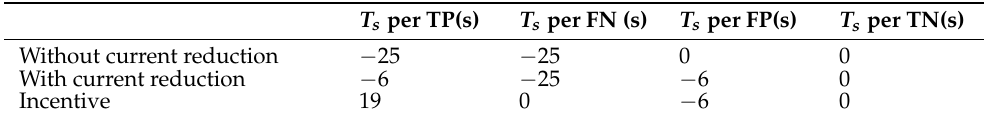
Figure 10. Expected lost beam time without ( top ) and with ( bottom ) the proposed 10% current reduction. An interlock equivalently leads to 25 s of lost beam time, i.e., − 25 s of beam time saved. With the current reduction, the interlock is expected to be avoided with a cost of six s of lost beam time, i.e., − 6 s of beam time saved. Table 6. Detail of beam time saved T s according to different classification result and action for one